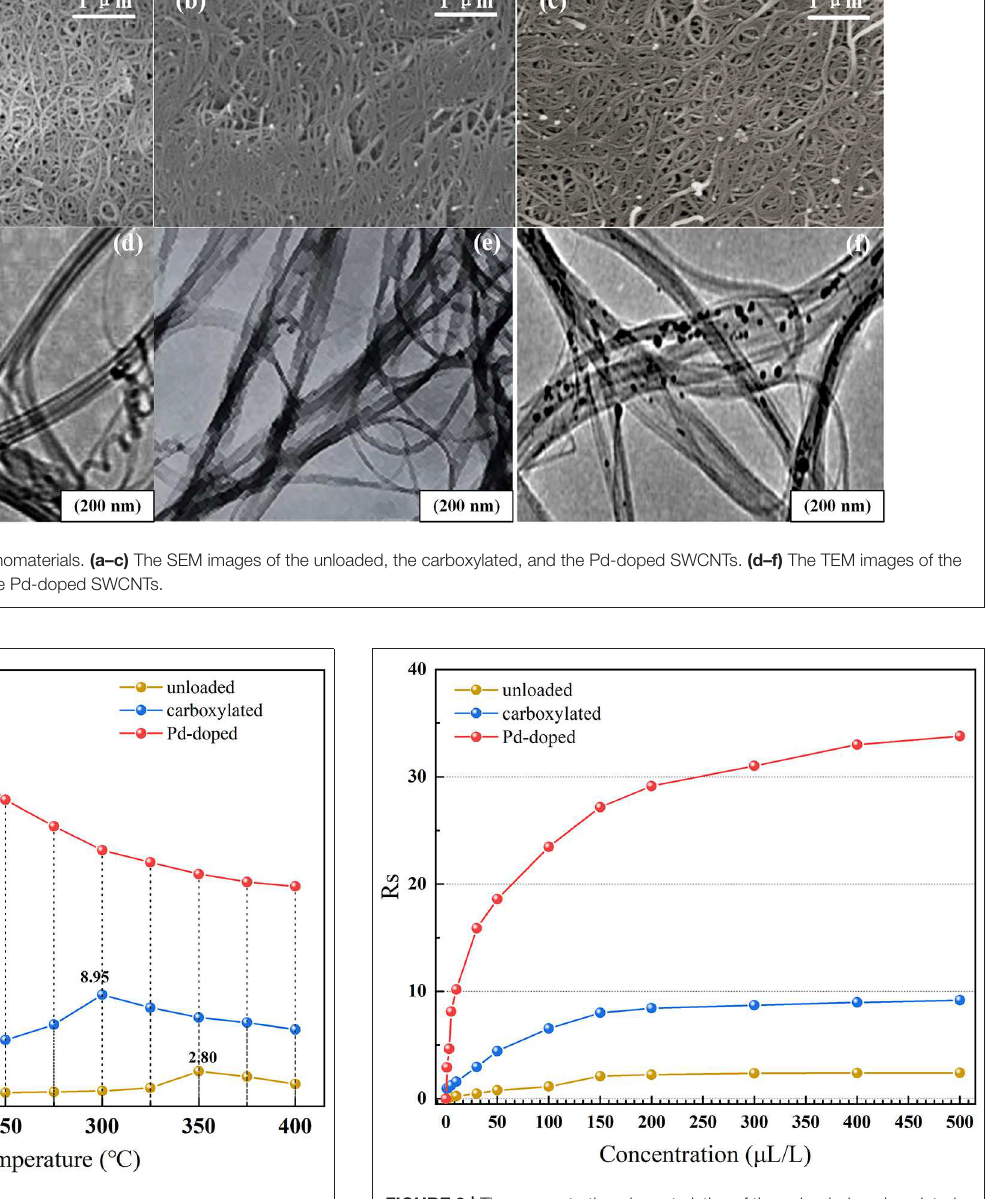
is not lower than 1, the corresponding gas sensor is able to reach the detecting limitation (International Standard IEC 60599: 2015, 2015; Tang et al., 2017). Results are shown in Table 1 . SWCNTs- based gas sensors with or without functionalization all show perfect linearity, while only the Pd-doped SWCNTs-based gas sensor can meet the requirement of detecting limitation. Figure 9 presents the response and recovery time characteristics of three gas sensors which were tested at 275 ◦ C to 50 µ L/L hydrogen. The experiment was repeated three times: 50 µ L/L hydrogen was injected at 50, 800, and 1,550 s, and was exhausted at 450, 1,200, and 1,950 s. It is obvious